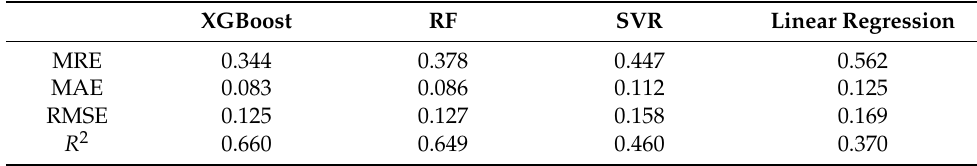
Table 7. Eight environmental factors used for